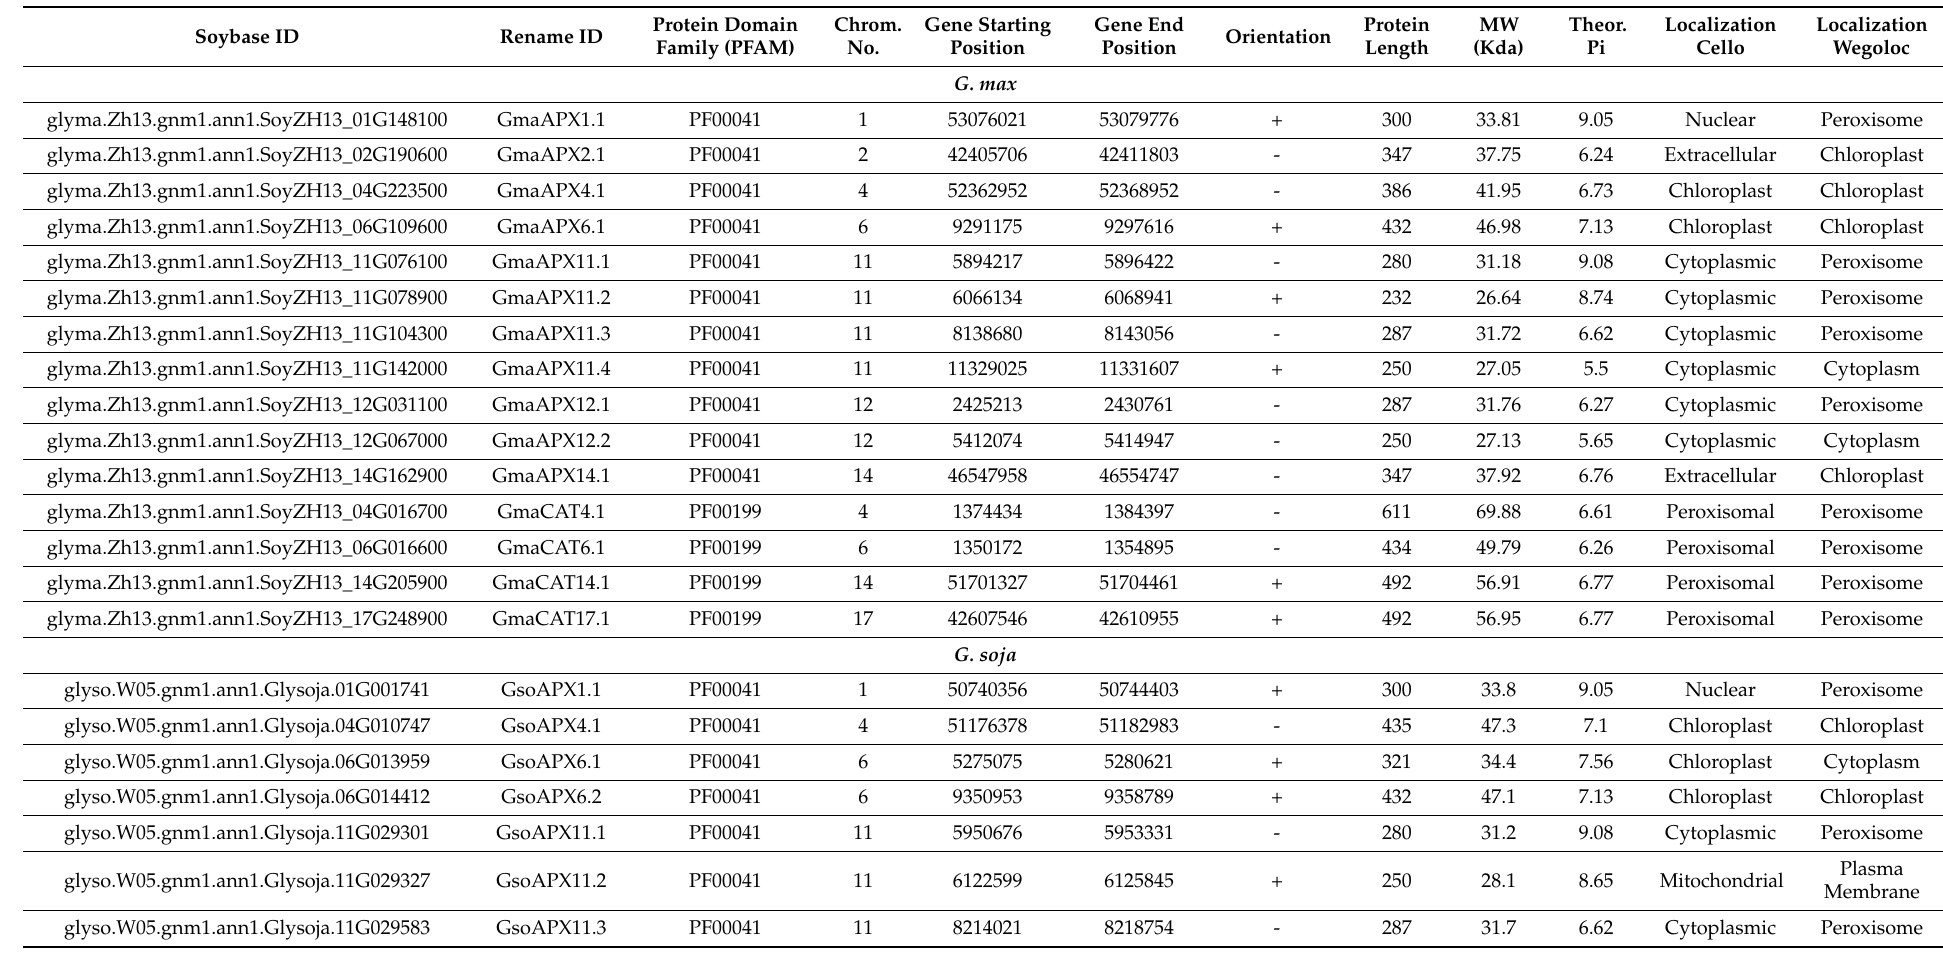
Table 1. Identified APX and CAT genes of wild and cultivated soybeans, including their soybase ID, rename ID, protein domain family and its description, chromosome number, location, orientation, protein size, molecular weight, PI and localization of the